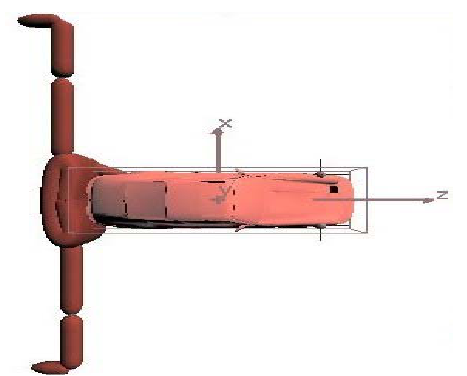
Figure 18 Results with Odd